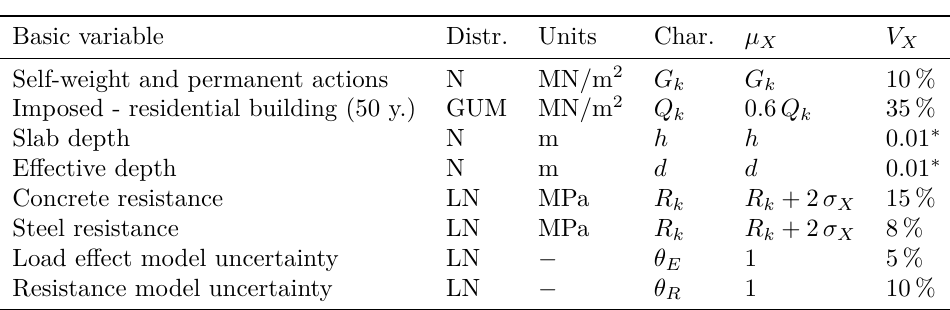
Table 1. Probabilistic models of basic variables [7,